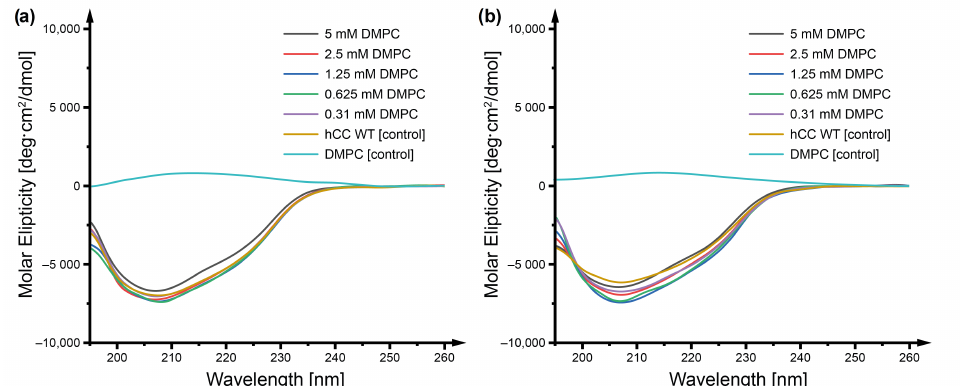
Figure 1. Circular dichroism spectra visualizing changes of the secondary structure of h CC V57G influenced by the environment DMPC liposome solution after 24 h of incubation at ( A ) 22 ◦ C and ( B ) 37 ◦ C. The h CC:liposome ratio calculated for C DMPC = 5 mM, equaled 16 h CC molecules per